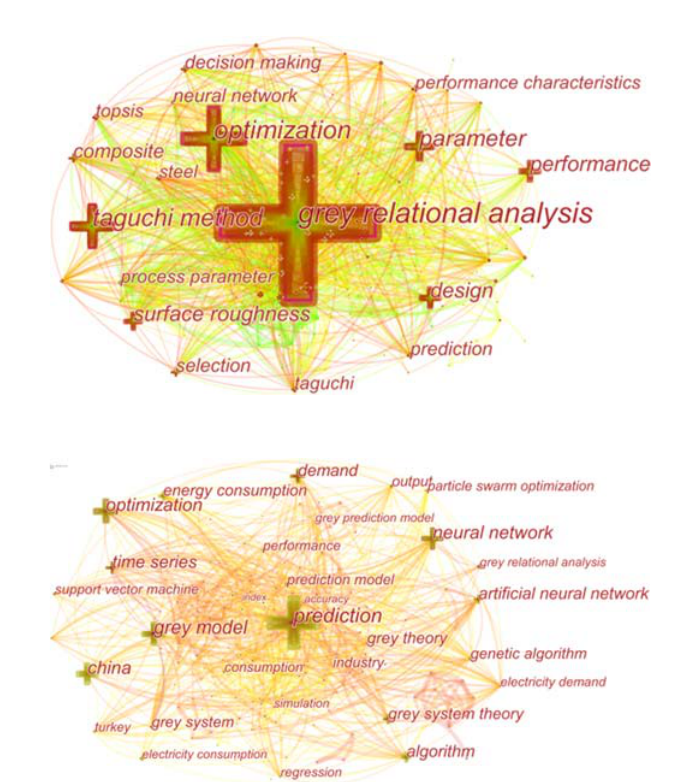
Figure 9. The keywords map of grey perdition